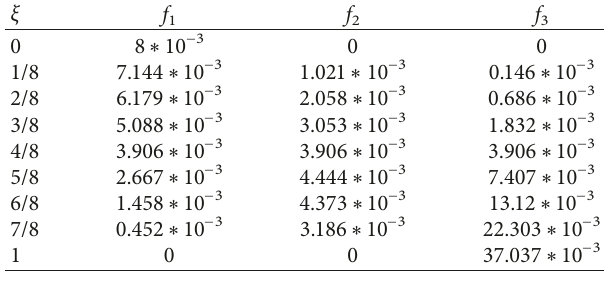
n � 8 parts. i using